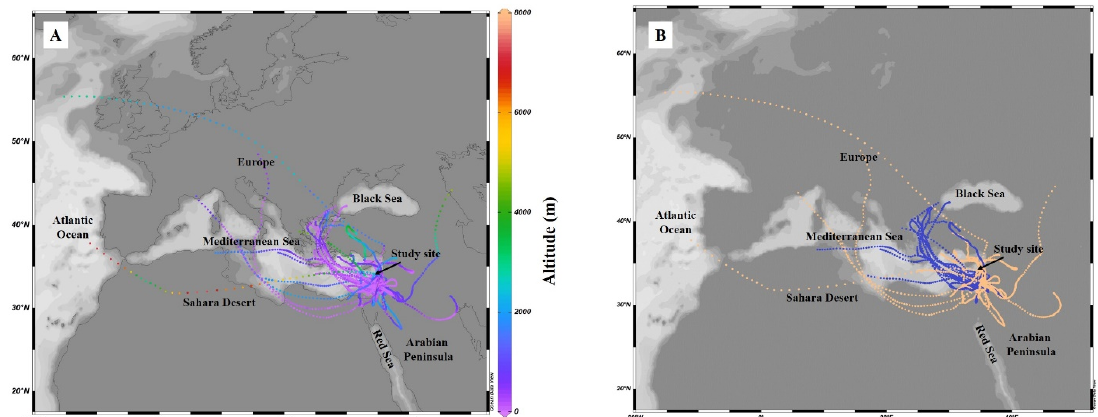
Figure 2. ( A ) Backward trajectories calculated with NOAA HYSPLIT model arriving at 10 m altitude to Tel-Shikmona, Haifa (SE Mediterranean coast) between 2015–2018 ( n = 34). ( B ) A summary of the main trajectories computed / calcified based on the route prior collection; marine (blue) and terrestrial (brown). Our measurements show that heterotrophic and autotrophic (cyanobacteria) airborne